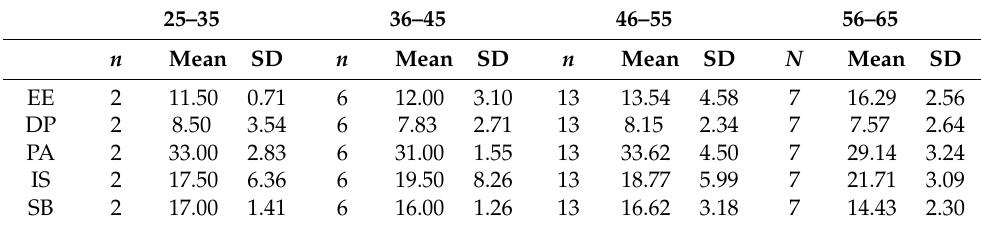
Table 6. Results of the dimensions by age.